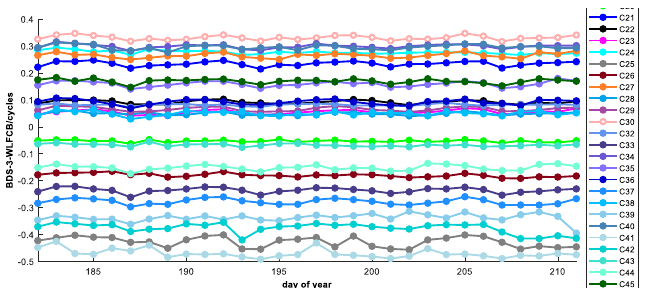
Figure 4. BDS-3 WL FCB (reference satellite is C19).